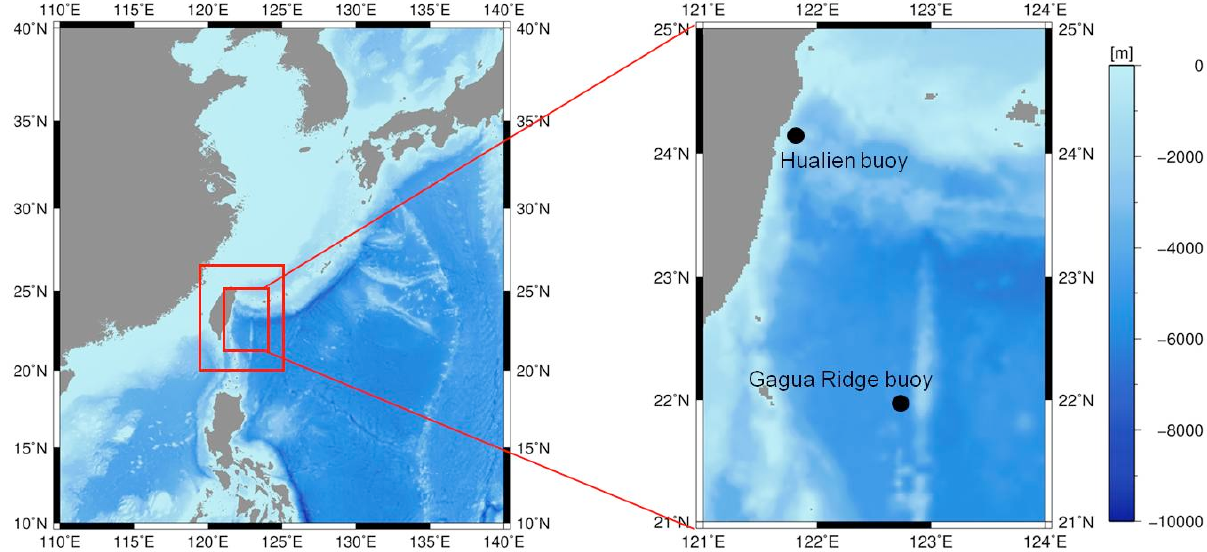
Fig. 1. Computational regions of the model and locations of data buoy